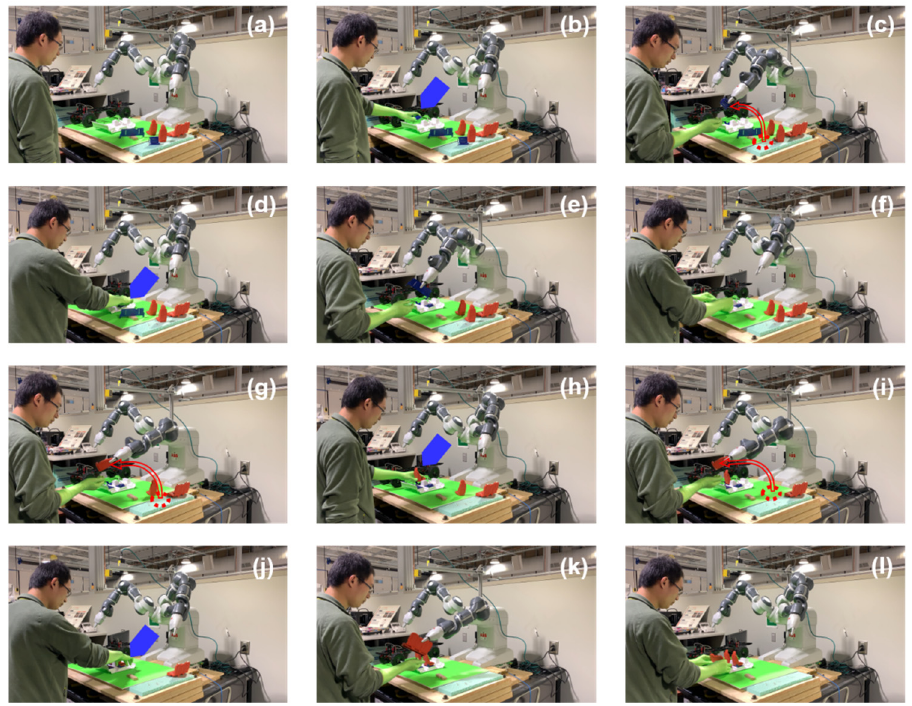
Figure 14. Human-robot collaborative assembly process in real experiment scenario. ( a ) Initial position; ( b ) human worker installs the left seat holder; ( c ) robot delivers the right seat holder to human; ( d ) human worker installs the right seat holder; ( e ) robot delivers the back seat holder to human; ( f ) human worker installs the back seat holder; ( g ) robot delivers the left seat to human; ( h ) human worker installs the left seat; ( i ) robot delivers the right seat to human; ( j ) human installs the right seat; ( k ) robot delivers the back seat to human; ( l ) human installs the back seat.